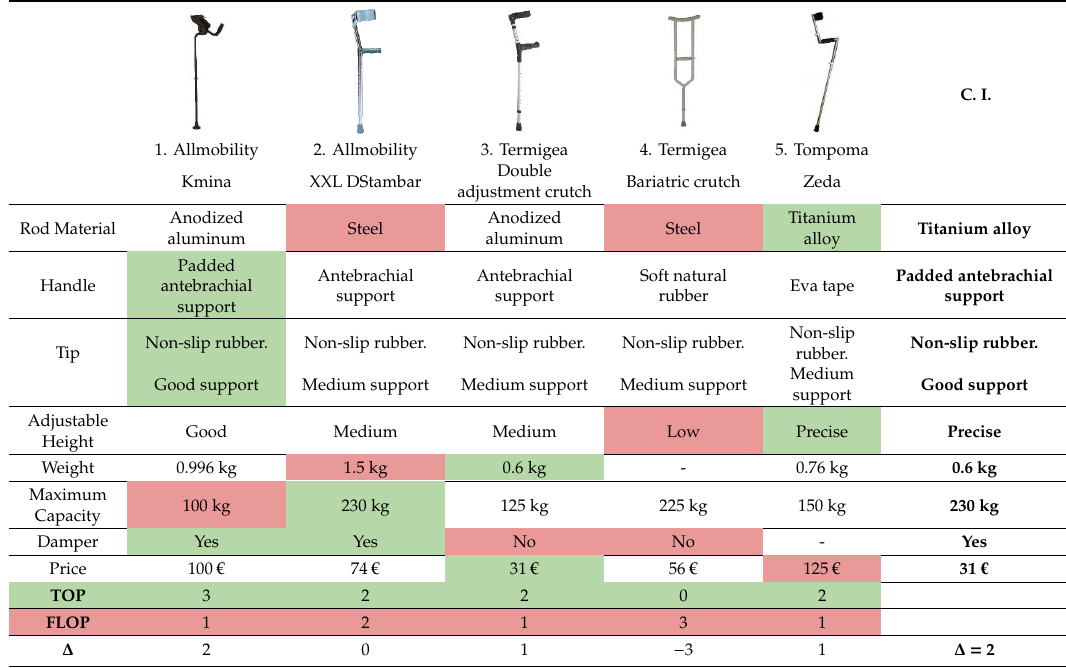
Table 4. Benchmarking and Top-Flop Analysis.